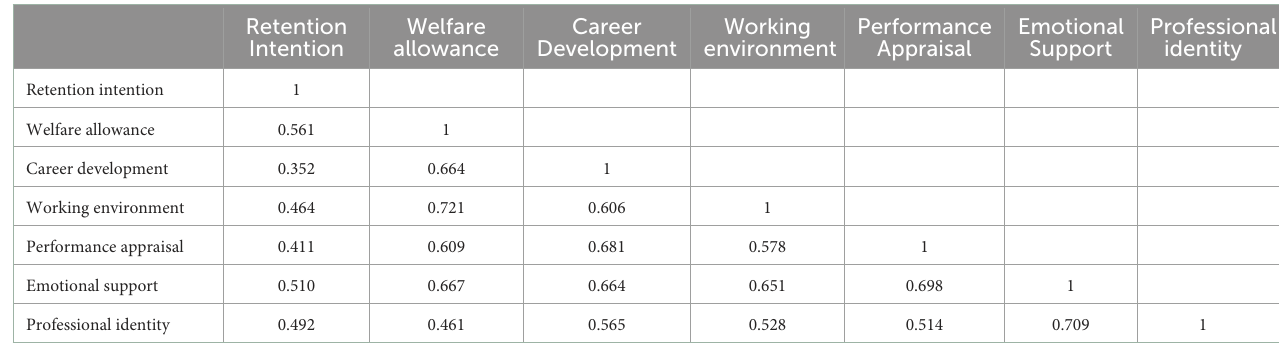
TABLE 4 Testing for